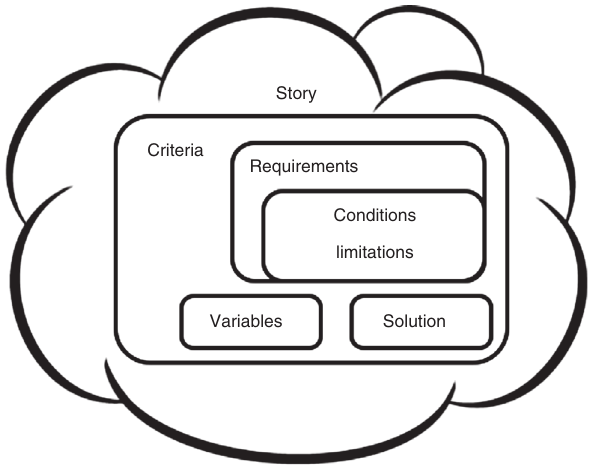
Figure 2. Real-Life Story